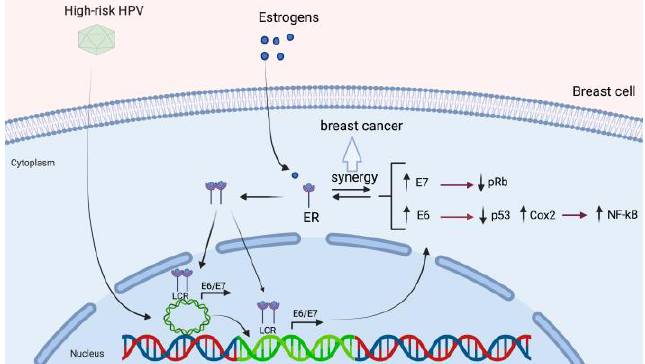
Figure 4. A suggested model of HPV-mediated breast carcinogenesis. Estrogens promote estrogen receptor (ER) activation and nuclear translocation. ER binding to cognate sites into the HR-HPV LCR promotes early promoter activation and E6/E7 transcript overexpression (in both episomal and integrated forms of HPV). The expressed E6 and E7 oncoproteins induce pRb and p53 downregulation, Cox-2 upregulation and NF- κ B activation. Additionally, a synergism between ER and HR-HPV E6/E7 has been previously proposed.